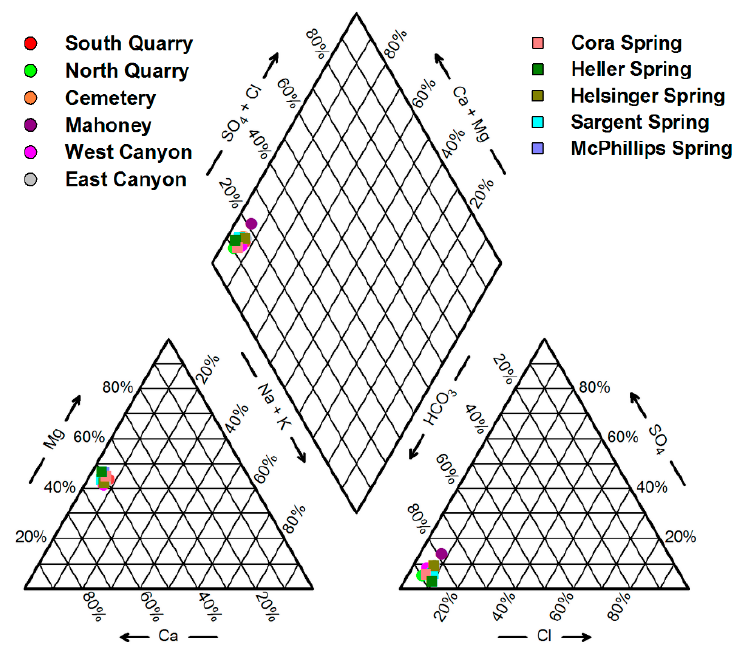
Figure 3. Piper plot showing the mean cation and anion compositions (% meq/L) for the stream and spring waters from the various locations during the monitoring period.